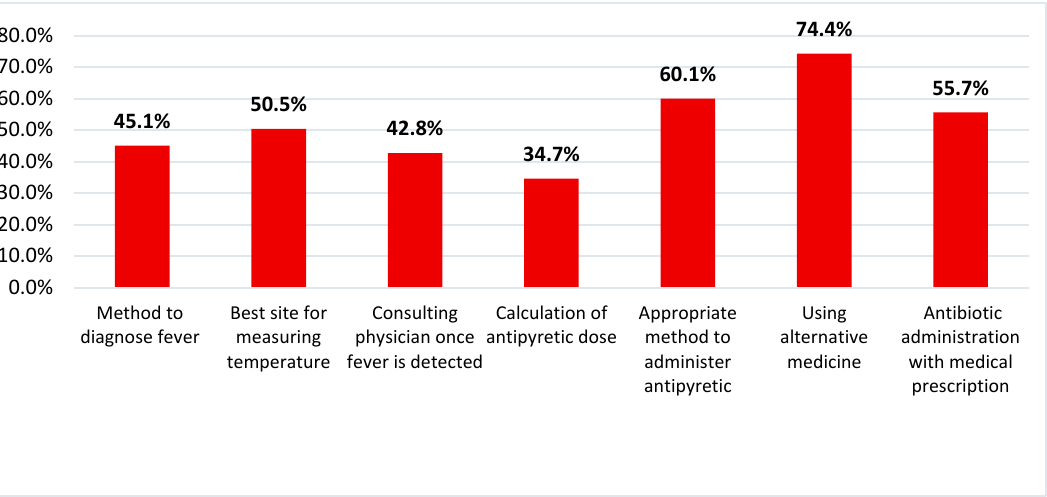
Figure 2. Percentages of correct management practices scores of mothers toward preschool childhood fever.